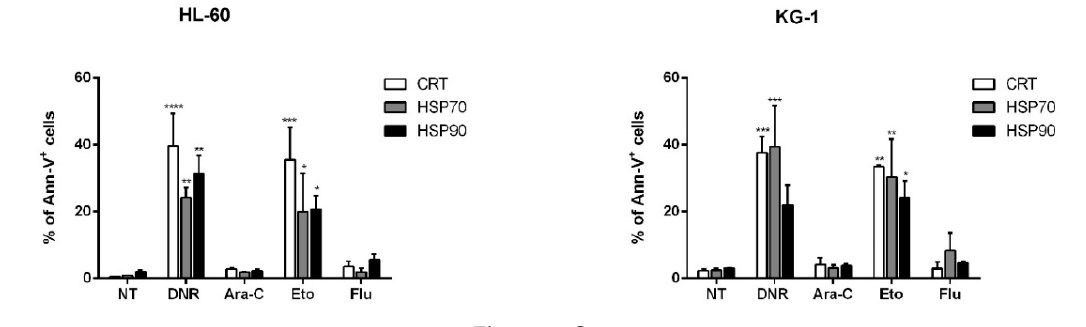
Figure 2. Flow cytometry analysis of calreticulin (CRT) and heat-shock protein (HSP) translocation on the cell-surface of acute myeloid leukemia (AML) cells after chemotherapy treatment. The HL-60, KG-1 and primary AML cells were treated with daunorubicin (DNR) (500 ng/mL), cytarabine (Ara-C) (20 µg/mL), etoposide (Eto) (20 µg/mL) and fludarabine (Flu) (70 µg/mL) for 24 h. The percentage of CRT + , HSP70 + and HSP90 + cells (gated on apoptotic Ann-V + cells) was analyzed by flow cytometry. Un-treated cells (no treatment; NT) were used as a negative control. The values are represented as mean ± SEM of 5 independent experiments. * p <0.05; ** p < 0.01; *** p < 0.001; **** p < 0.0001 compared to un-treated cells. As shown in Figure 3, flow cytometry data regarding CRT translocation were also confirmed using immunofluorescence. Taken together, these in vitro data indicate that Eto is comparable to DNR in early ICD event induction. In contrast, Flu treatment is not capable of inducing either CRT or HSP translocation, similarly to Ara-C treatment.